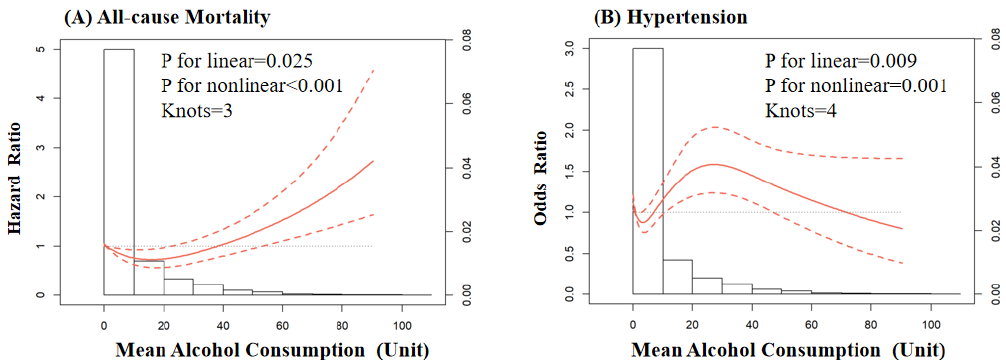
Figure 2. Curvilinear association of mean alcohol consumption with all-cause mortality ( A ) and newly onset hypertension ( B ). Panel ( A ) was conducted with restricted cubic spline using Cox regression model. Panel ( B ) was conducted with restricted cubic spline using logistics regression model. Both panels ( A , B ) were adjusted for age, sex, marital status, education, residence area, smoking status, mean BMI, mean waist circumference.